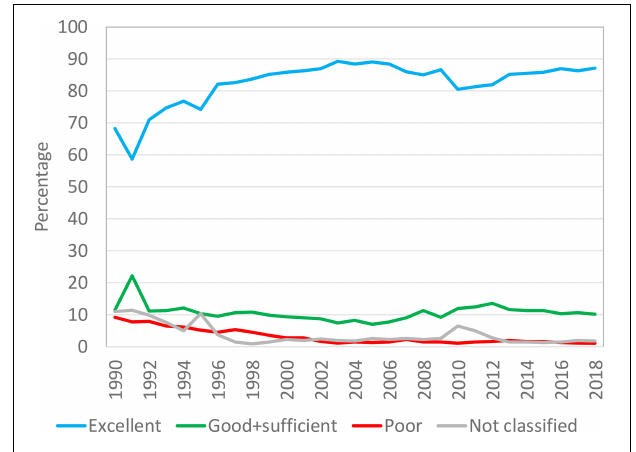
FIGURE 3 | Evolution of the quality in > 15,000 European beaches, under the Bathing Water Directive. Source: https://www.eea.europa.eu/themes/water/europes-seas-and-coasts/